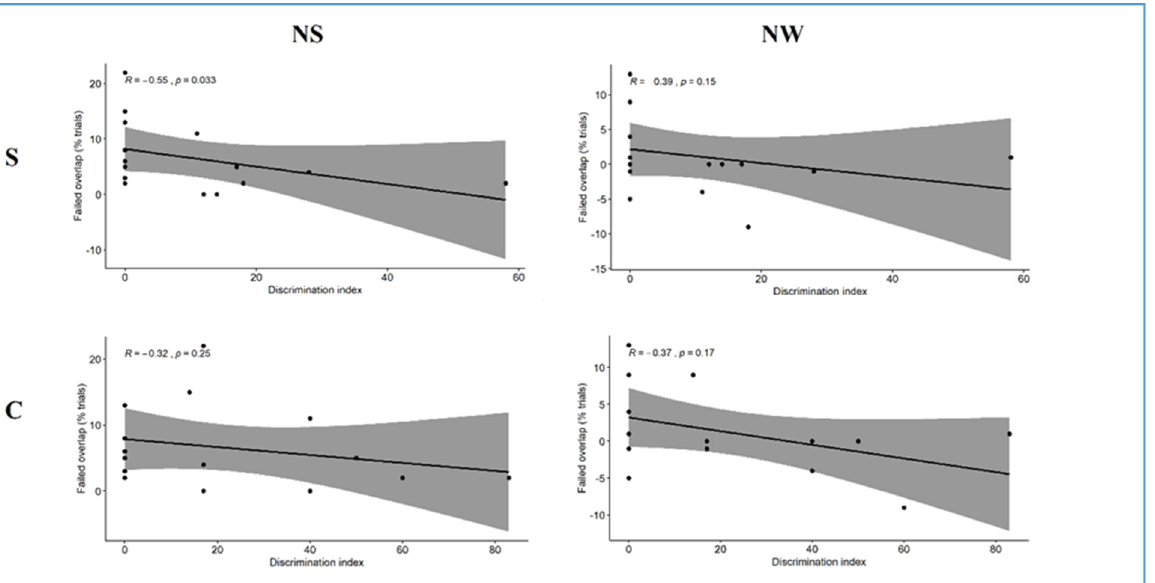
Figure 6. Spearman correlation plot of the percentage of trials without disengagement of attention in the simple (S) and complex (C) overlap conditions at 4 months, and the discrimination index during the novel strong (NS) and novel weak (NW) conditions on the syllabic discrimination task at 7 months. R = Spearman’s rank correlation coefficient.